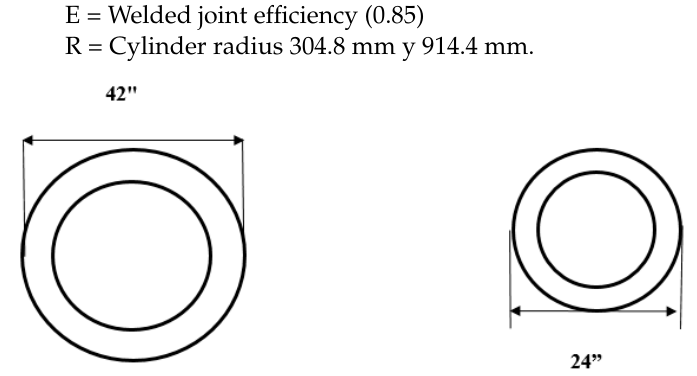
Figure 8. Circular covers of vertical cylinders.